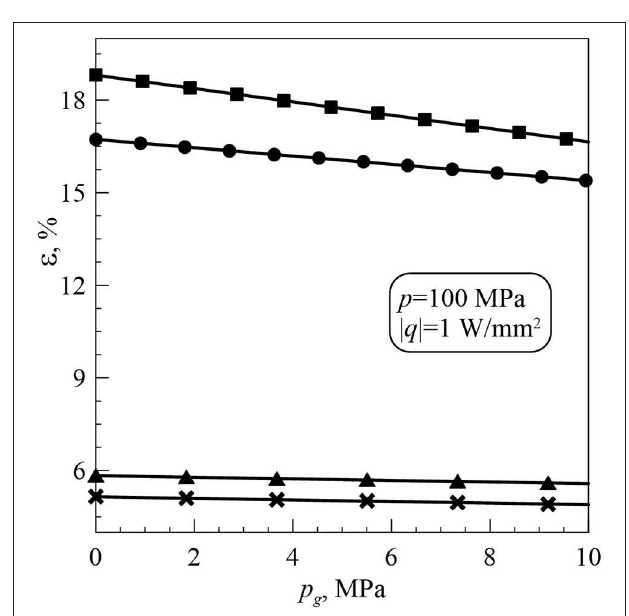
FIGURE 7 | The thermal rectification index ε vs. the gas pressure p g q . | |